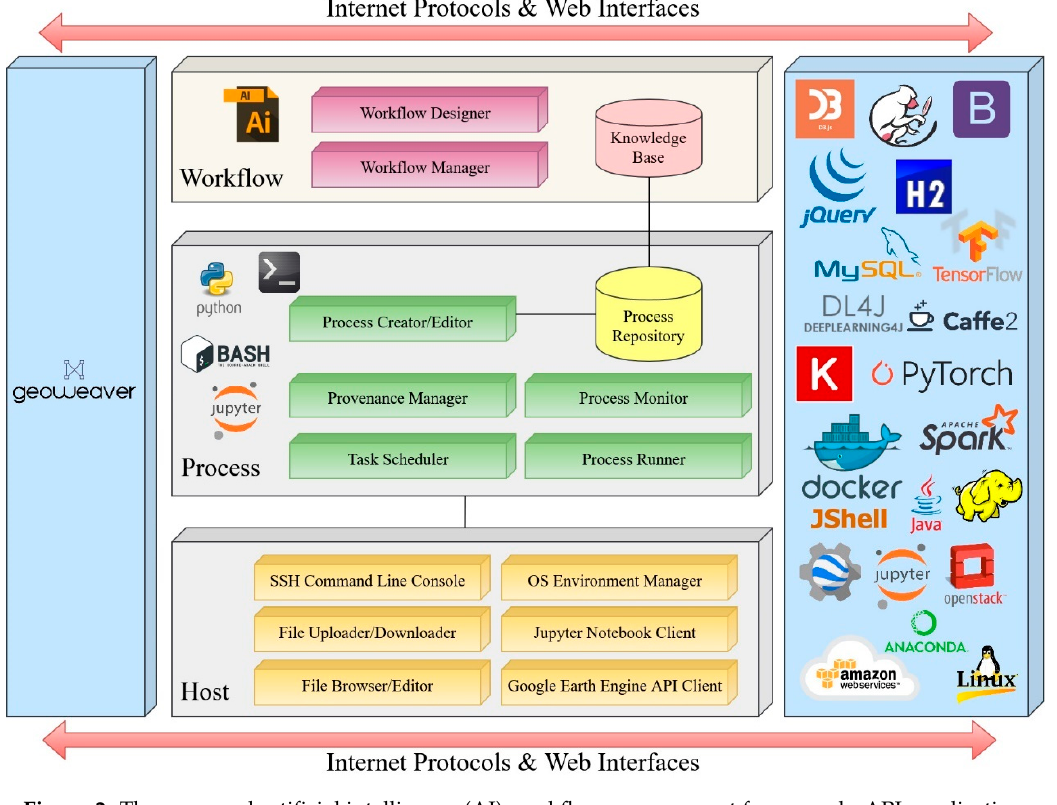
Figure 2. The proposed artificial intelligence (AI) workflow management framework. API, application programming interface. (OS: Operating System)